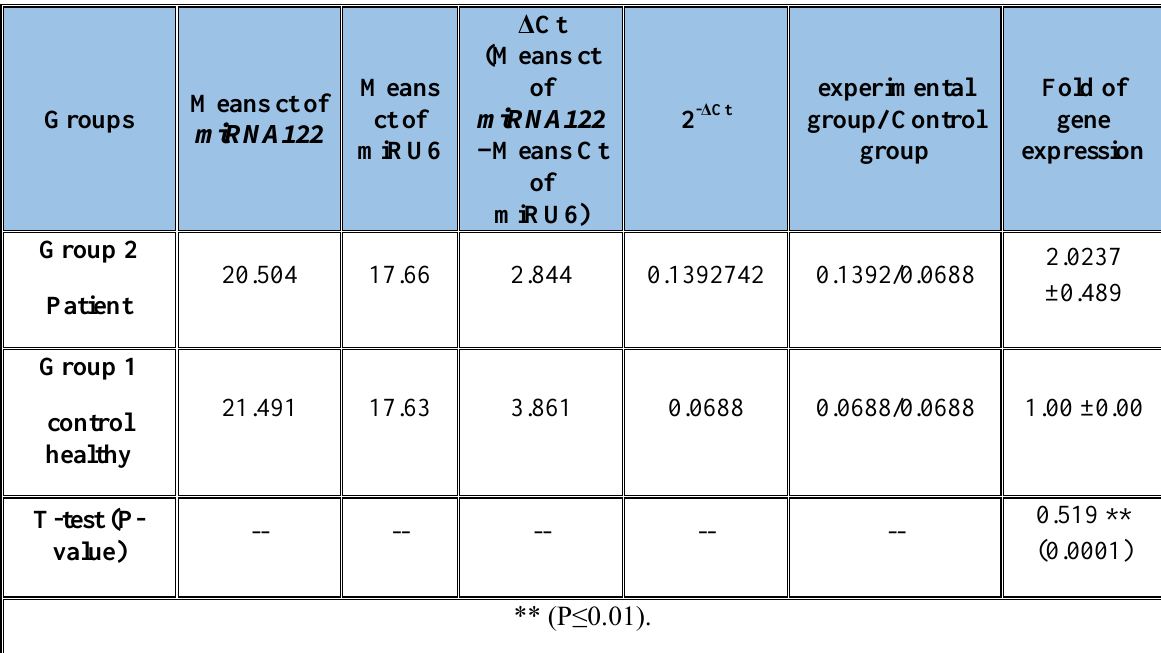
Table 6: Fold of miRNA 122a expression Depending on 2 -ΔCt Method.